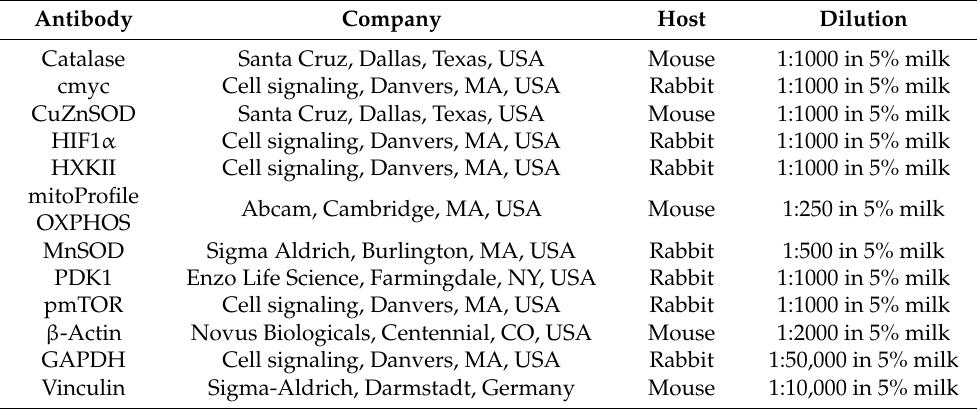
Table 1. Antibodies used for Western